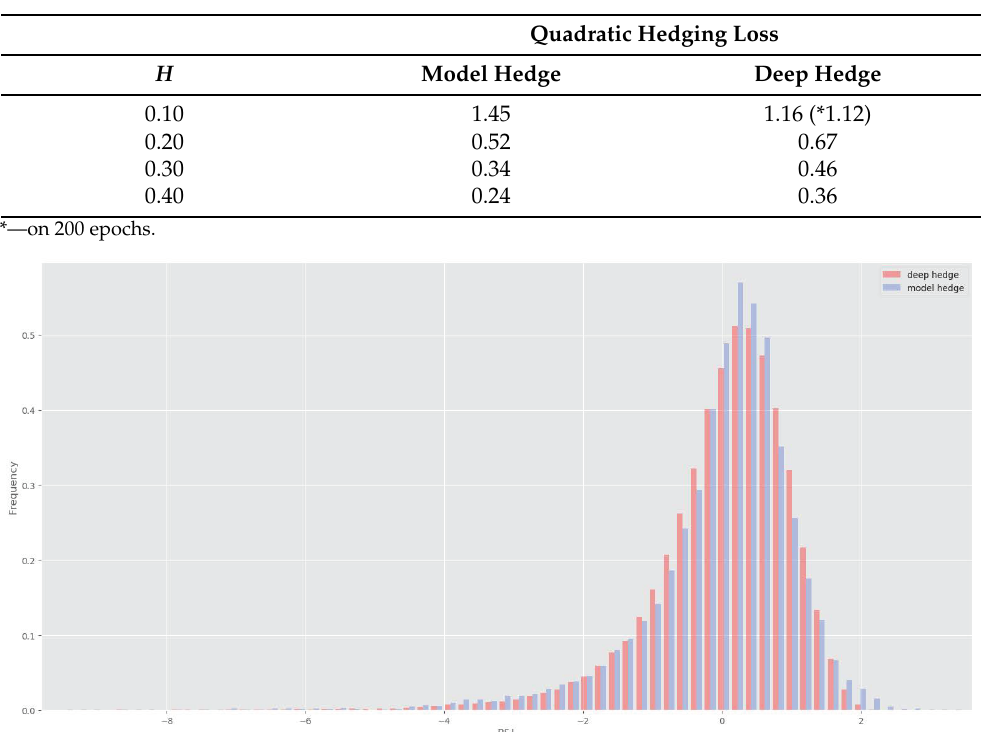
Table 1. Comparison of the quadratic loss between model and deep hedges trained 75 epochs for different H .